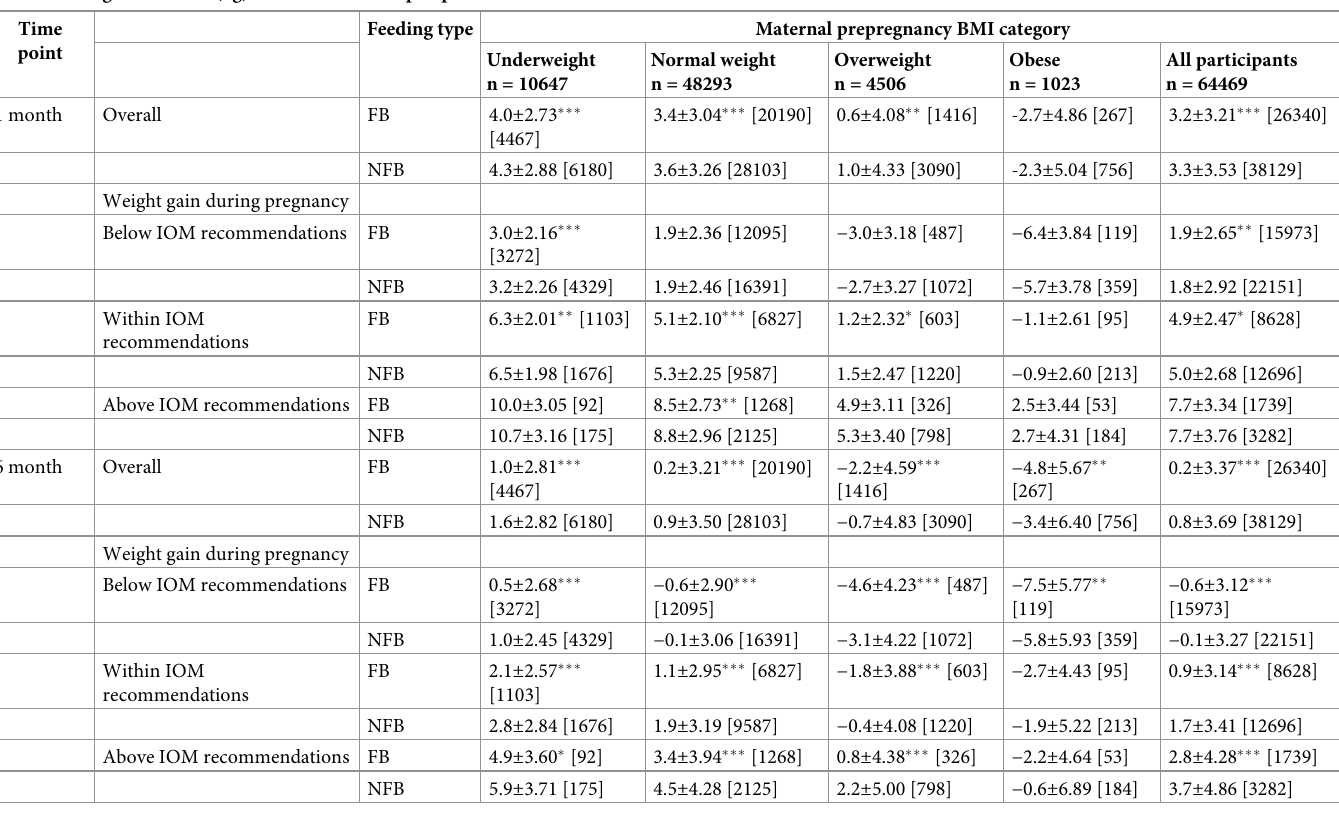
Table 3. Weight retention (kg) at 1 and 6 months